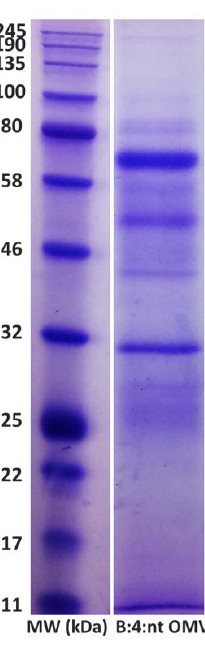
Figure 2. Electrophoretic profile of N. meningitidis Outer membrane vesicles (OMVs) from strain B:4:nt stained with Coomassie Blue. At the left, the molecular weight (MW) marker ranging from 11 to 245 kDa.